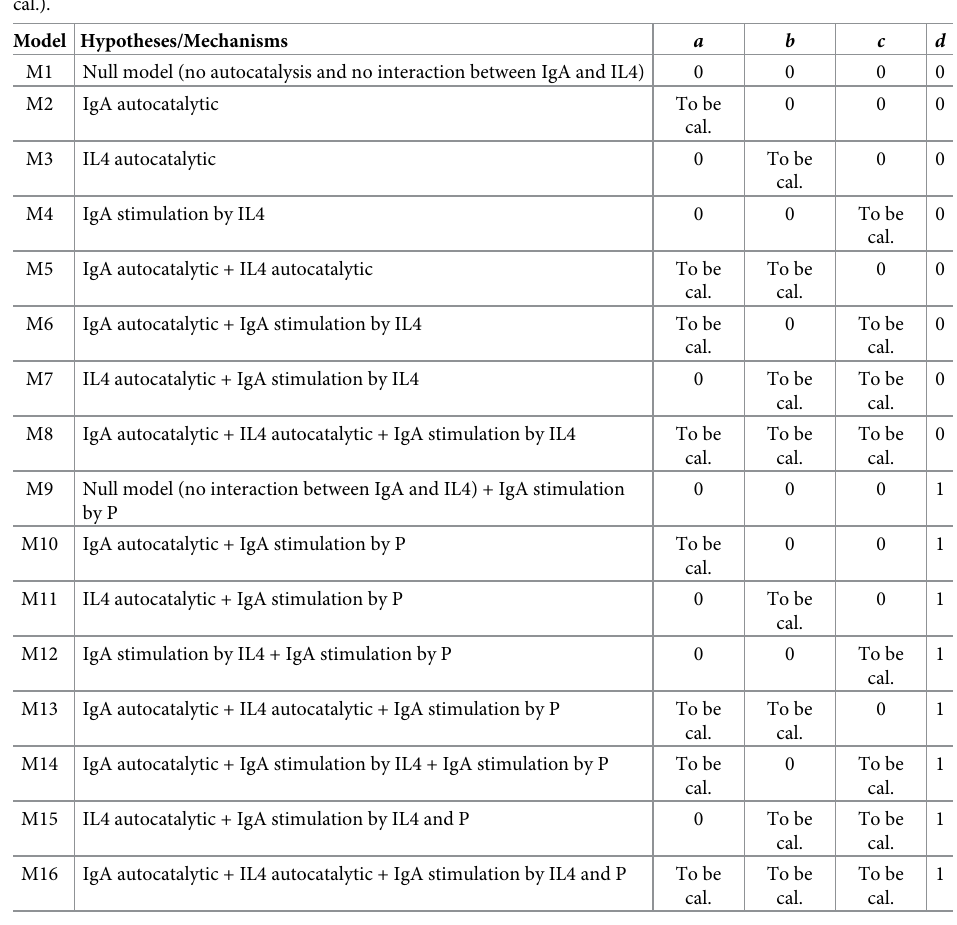
The baseline equilibrium value of IgA in the blood, � I are available from the control rabbits [31, 32]. The decay rates of specific IgA, δ are provided by infections on the same system, where rabbits were treated with an anthelmin- tic and the immune response quantified just before the treatment and one month later, during which animals were kept untouched [34]. The baseline production rates Λ mated as � I d and � I d , from Murphy et al. [31]. The development rate of larvae into adults, 1 i 1 i 2 i 2 i , is assumed to be fixed but different between the two helminths [36, 37], while natural para- k i site mortality rate, μ , is assumed to be mainly caused by the natural mortality rate of the host, whose lifespan has been set equal to one year [38]. The remaining parameters σ and c are calibrated to estimate the contribution and degree of responses of P , I b i i Model calibration was performed by minimizing the following error function, ERR , calcu- lated as a weighted sum of the variable under study errors, using their sample size as weights, , n and n : n P I 1 I 2